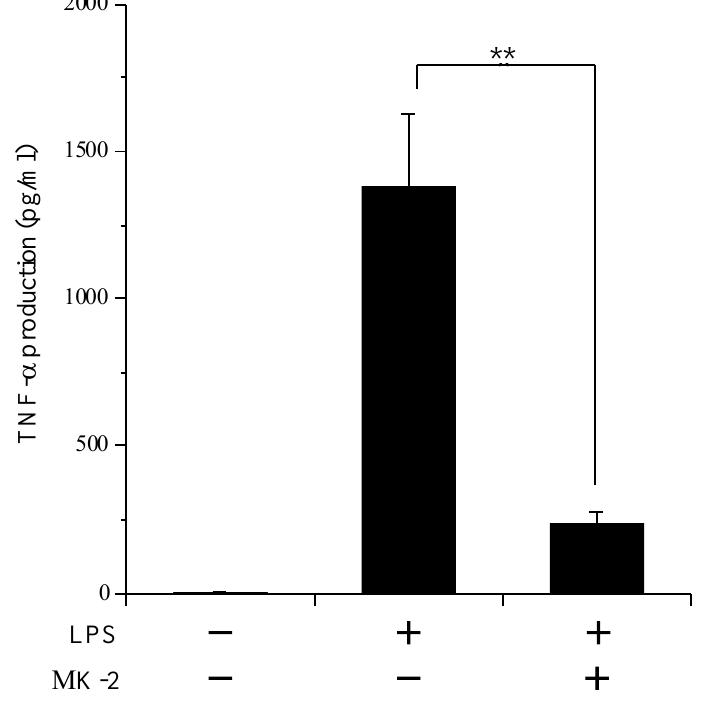
Figure 6. The inhibitory activity of MK-2 against LPS-induced inflammation in vivo . Female C57BL/6 mice were intraperitoneally injected with MK-2 at 100 mg/kg BW or corn oil as a vehicle control. After 30 min, the mice were intraperitoneally injected with LPS at 250 κg/kg BW or saline as a vehicle control. One hour after the LPS injection, the mice were killed, and the TNF-α level in serum was measured using ELISA. Treatment with corn oil and LPS was a positive control (TNF-α level, 1376 pg/mL), and that with corn oil and saline was a negative control (TNF-α level, 4.2 pg/mL). Data are shown as the mean ± SE ( n = 5). ** P < 0.01 versus the